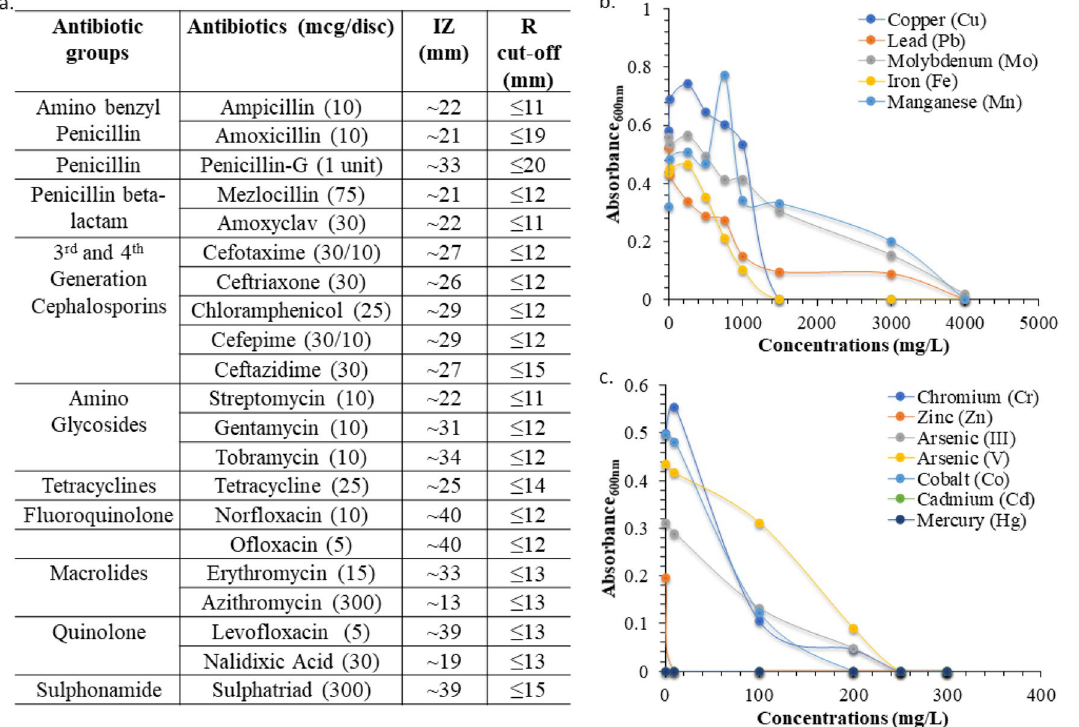
Figure 1. Multi-drug and multi-metal tolerance capacity of BMCSI 3. Antibiotic sensitivity against different antimicrobial agents ( IZ inhibition zone; R resistance) ( a ); metal tolerance capacity against different heavy metals ( b , c ).